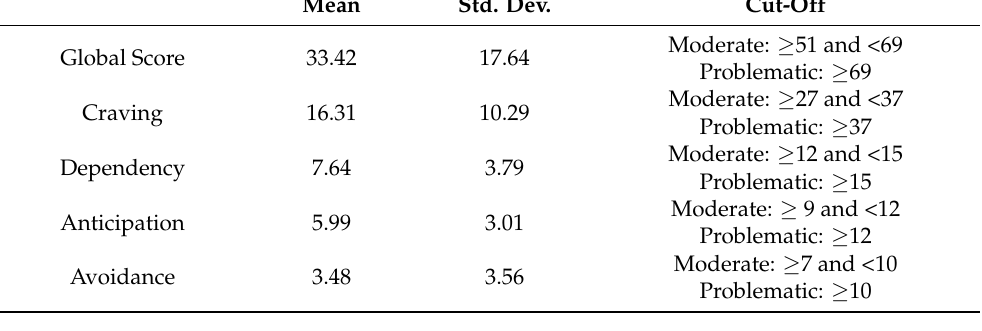
Table 6. Mean, Standard Deviation, and Cut-Offs of the BWAQ global score and subscales.